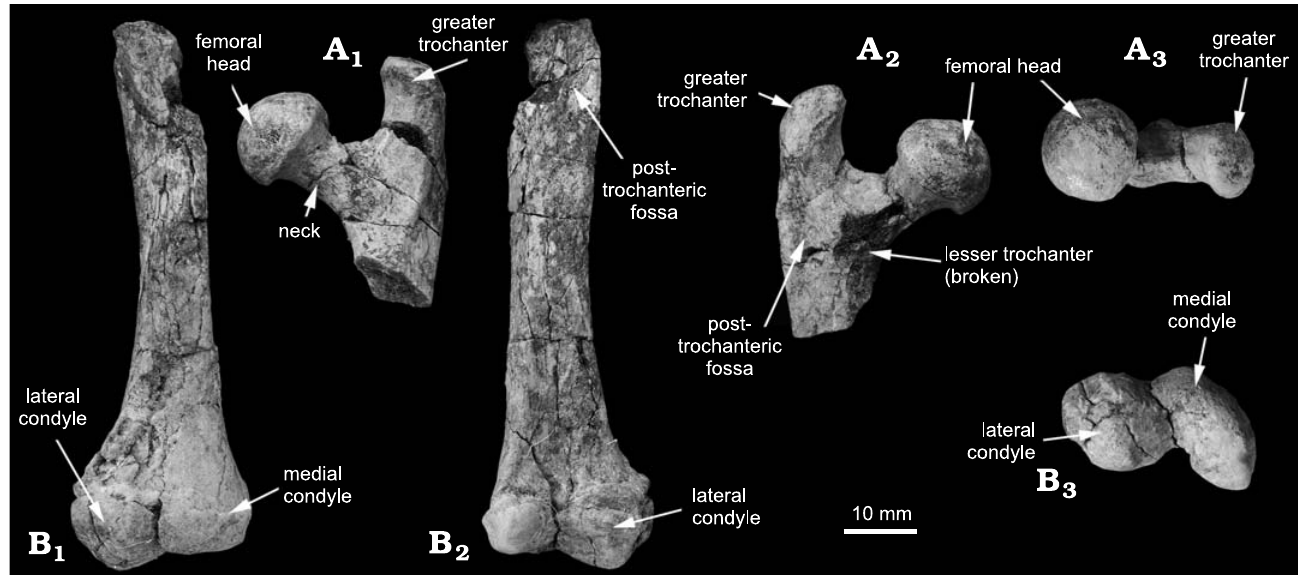
Fig. 12. The femur of multituberculate mammal Sphenopsalis nobilis Matthew, Granger, and Simpson, 1928 (IVPP V19030) from the upper Paleocene Nomogen beds at the Erden (Urtyn) Obo locality, Inner Mongolia, China. A . Proximal portion of the left femur in anterior (A 1 ), posterior (A 2 ), and prox- imal end (A 3 ) views. B. Right femur (with proximal end broken) in anterior (B 1 ), posterior (B 2 ), and distal end (B 3 )